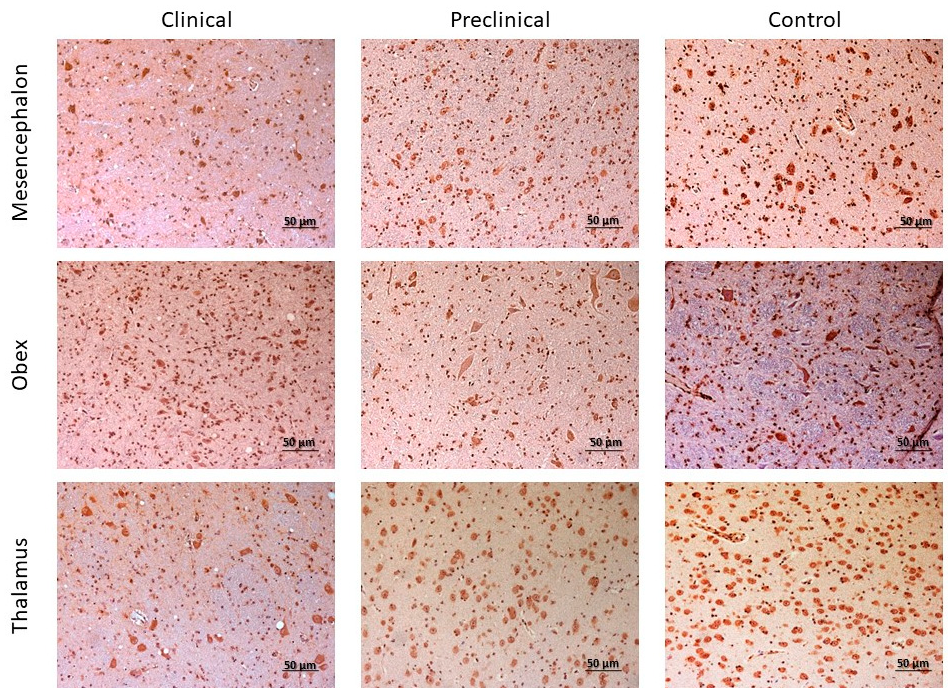
Figure 11. Immunostaining patterns of 5hmC in the mesencephalon, obex, and thalamus of preclinical, clinical, and control sheep.